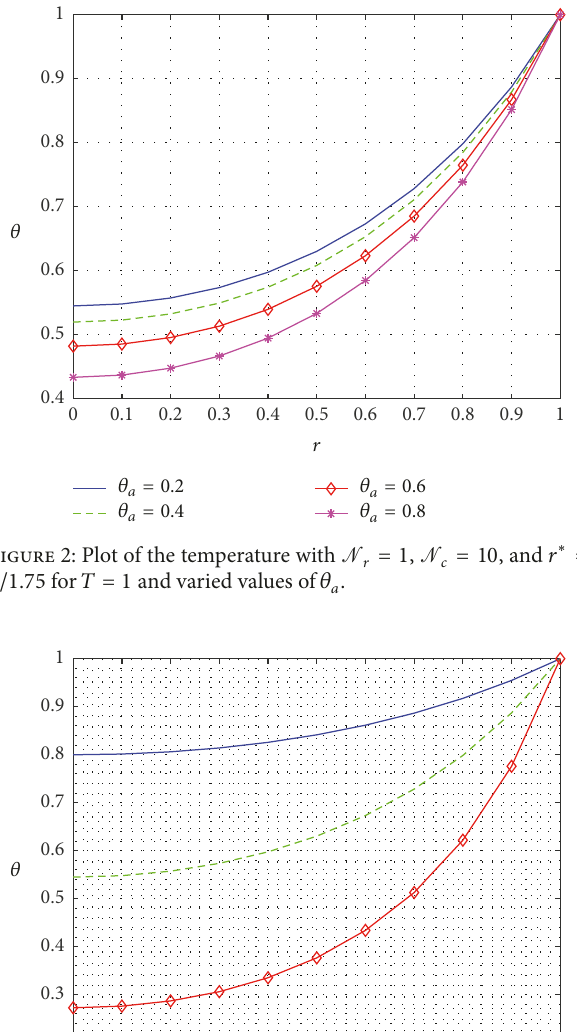
Table 3: Maximum error computed between the respective numer- ical solutions obtained, where E = max | CN sol − CN NR sol | , and their respective temperatures at the tip of the fin for varied values of N 𝑐 .